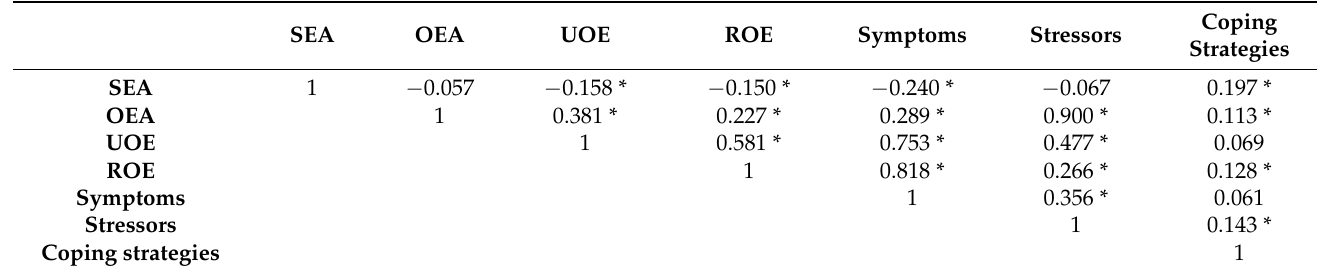
Table 2. Bivariate correlations between EI and academic stress categories for females.